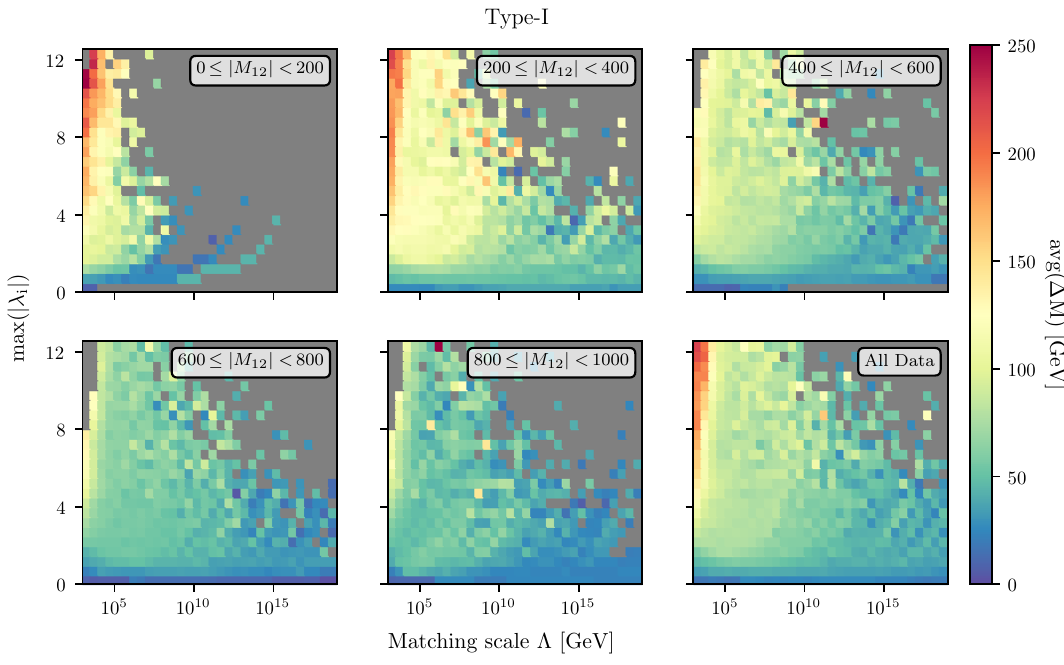
Fig. 5 Same as Fig. 4 but with the per-bin average of (cid:13) M instead of the maximal value